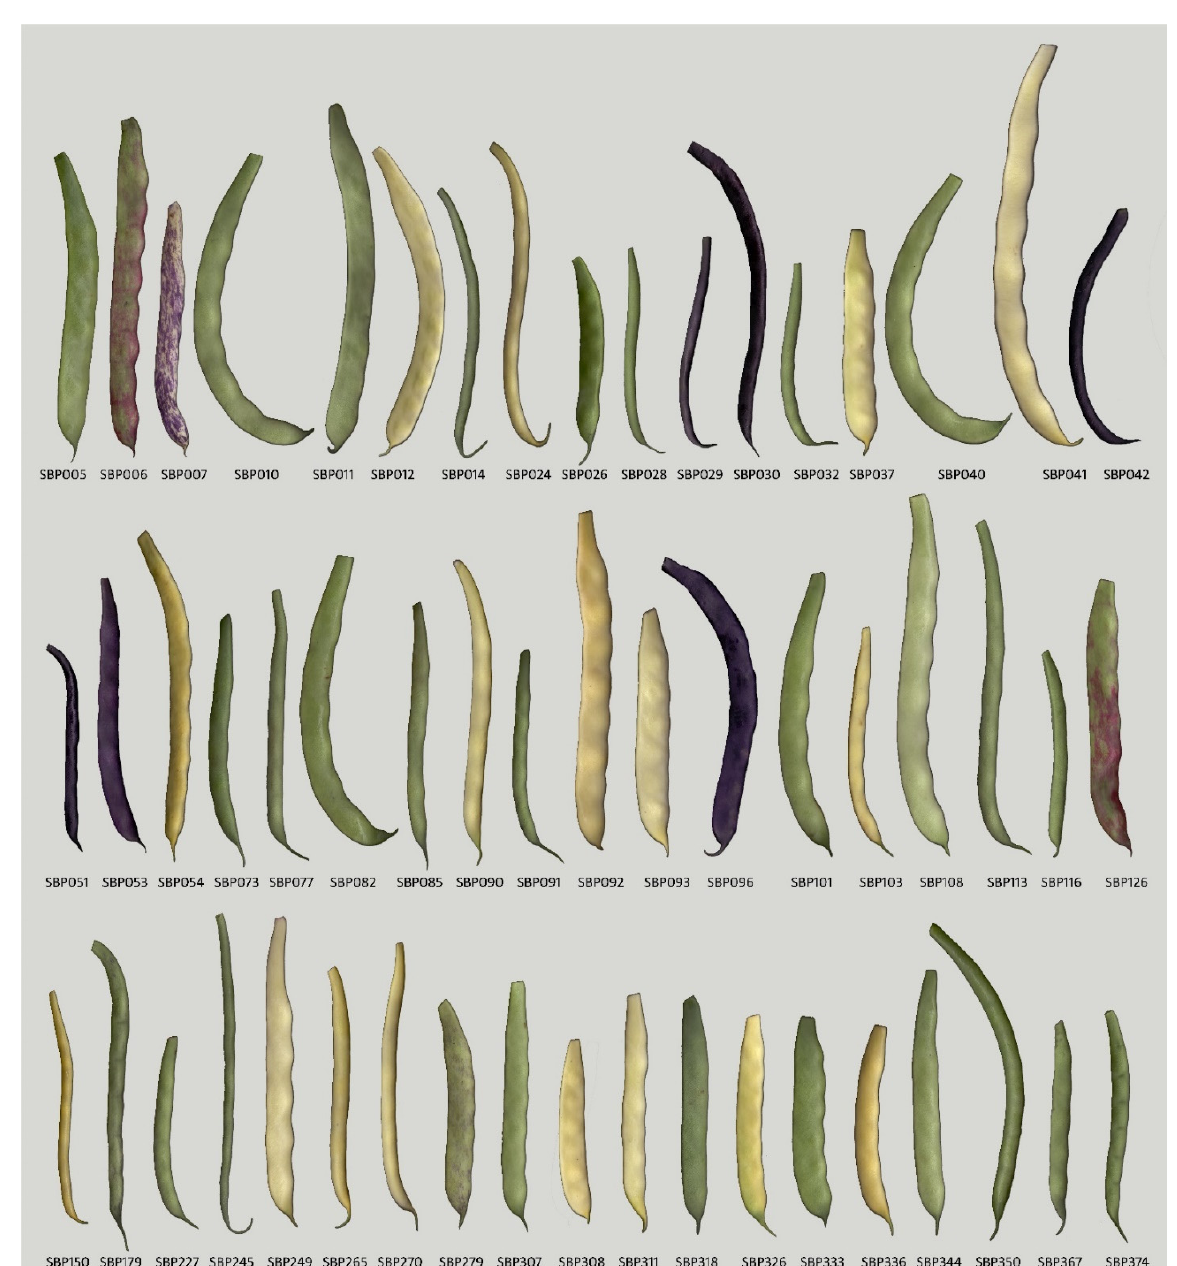
Figure 2. Immature pod phenotype of the 54 lines included in the Core-SBP. Pods were scanned at 300 dpi. 300